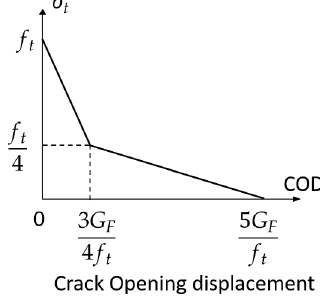
Figure 5. Tensile softening model of the concrete.